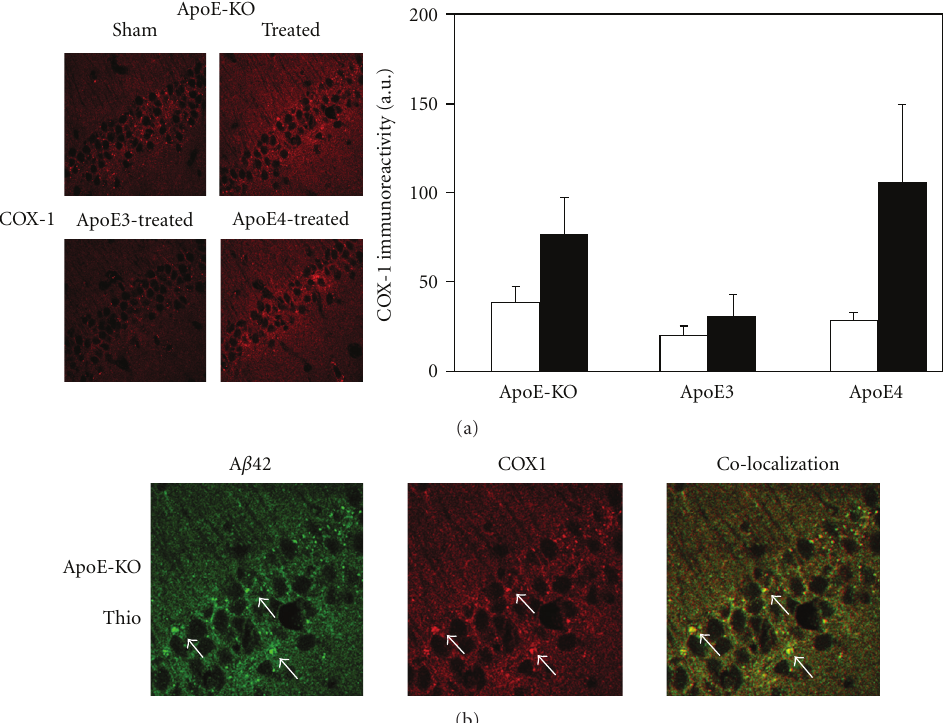
Figure 4: The e ff ects of apoE3, apoE4, and apoE deficiency on the mitochondria of hippocampal CA1 neurons following inhibition of neprilysin. ApoE3, apoE4, and apoE-deficient male mice were injected i.c.v. with the neprilysin inhibitor thiorphan or sham-treated for 10 days, after which their brains were excised and subjected to COX-1 immunofluoresence as described in “Materials and Methods.” (a) Representative coronal sections of sham- and thiorphan-treated apoE-deficient mice (upper row) and thiorphan-treated apoE3 and apoE4 mice (lower row) immunostained with anti-COX-1 are shown on the left (bar = 50 μ m). Quantification of the density of staining (mean ± SEM; n = 4–5mice/group in the sham- and thiorphan-treated groups) in the CA1 neurons of the indicated mice is shown on the right (empty and filled bars correspond, resp., to sham- and thiorphan-treated mice). P < . 03 for the e ff ects of treatment on the three mouse groups by Two-way ANOVA. (b) Representative confocal images of the co-localization of A β 42 and COX-1 in the CA1 area of apoE-deficient mice treated with thiorphan for 10